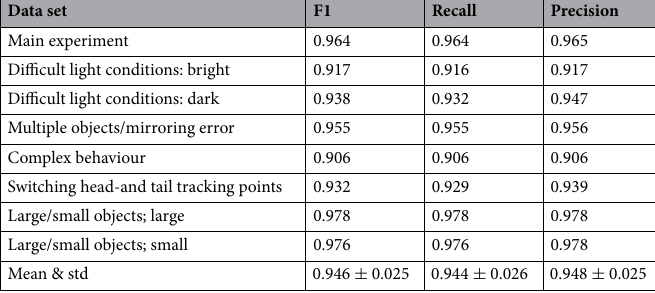
Table 1. Performance metrics (weighted) evaluated on all data sets